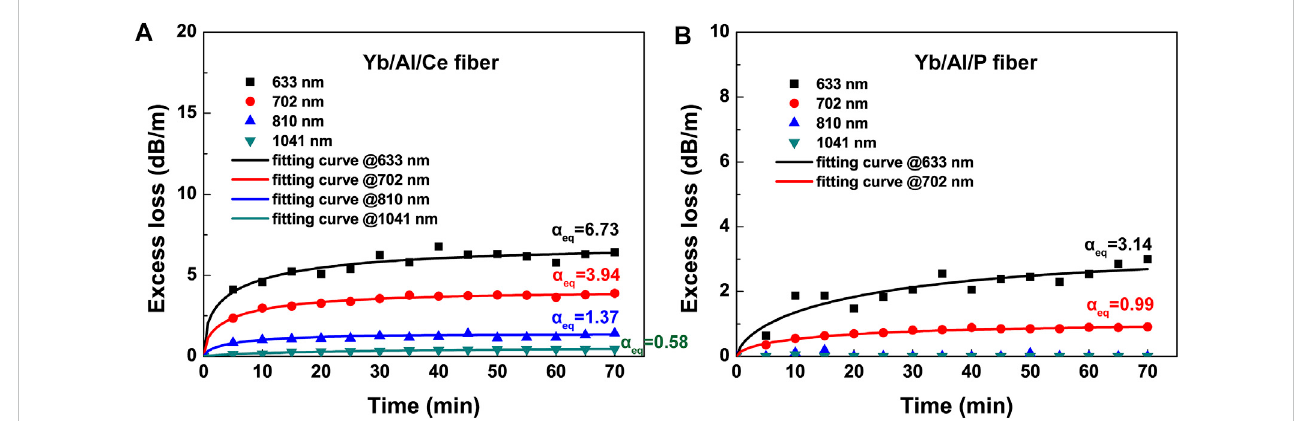
FIGURE 7 Laser performances in co-pumped ampli fi er. Yb/Al/Ce fi ber: (A) output power and O-O ef fi ciency dependence on the pump power; (B) time- and frequency-domain signals. Yb/Al/P fi ber: (C) output power and O-O ef fi ciency dependence on the pump power; (D) time- and frequency-domain signals.